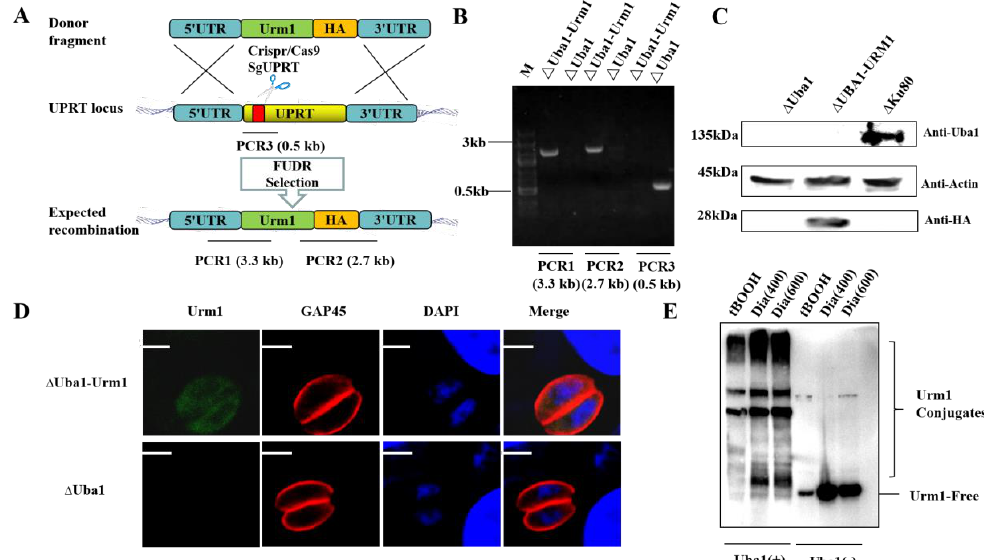
Figure 6. Effects of TgUba1 on TgUrm1 oxidative conjugation. ( A ) Schematic representation of TgUrm1-HA mediated UPRT gene deletion in T. gondii . The red bar indicated the sgRNA target region. ( B ) Performance of confirmatory PCR using genomic DNA as template from ΔUba1 and transfected parasite clones. ( C ) Immunoblotting demonstrating expression of epitope-tagged TgUrm1-HA. ( D ) Immunofluorescence (IFA) of ΔUba1 -Urm1 using anti-HA antibodies. Scale bar, 2.5 μm . ( E ) Total tachyzoite lysates resolved by SDS/PAGE and subjected to anti-HA western blotting. The treatment were as follows: 10 −4 M tBOOH for 2 h, 400 and 600 μM of Dia for 10 min. tBOOH (tert-butyl hydroperoxide) was an oxidative stress inducer. “+” indicated the presence of TgUba1 gene in parasites, and “−” indicated the absence of TgUba1 gene.